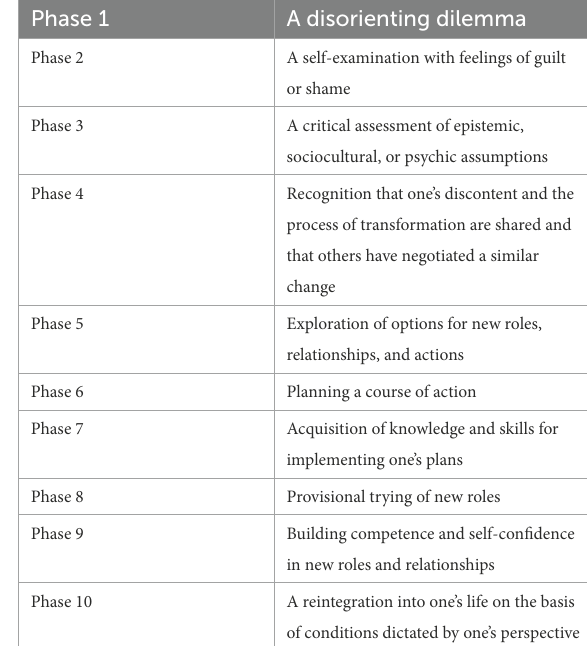
TABLE 2 Ten phases of transformative learning Mezirow’s